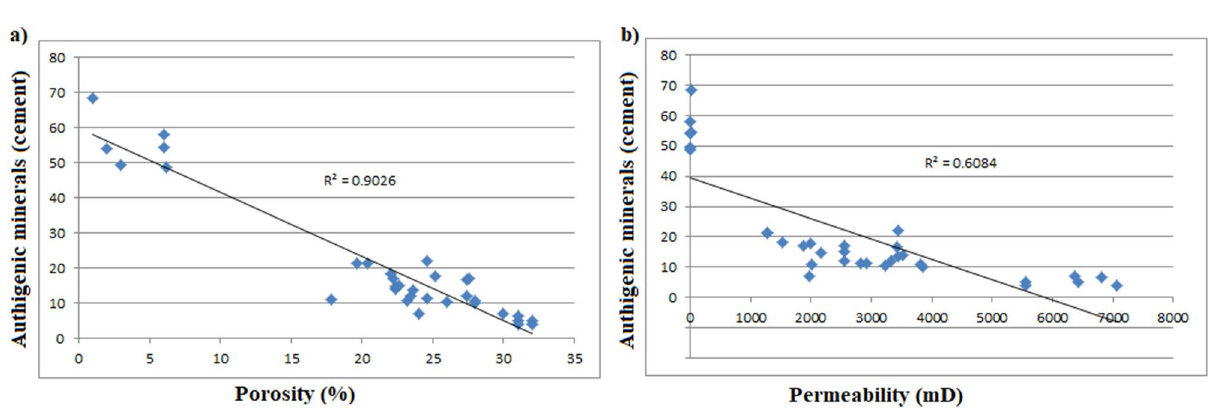
Figure 16. Cross-plots illustrating a good inverse correlation between authigenic mineral cements and porosity and permeability. Presence of this cements reduces the reservoir